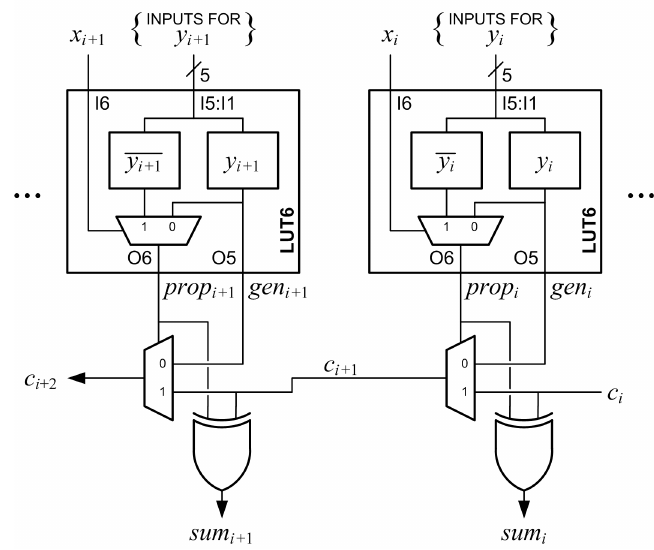
Figure 2. Proposed two-operand adder, computes SUM = X + Y